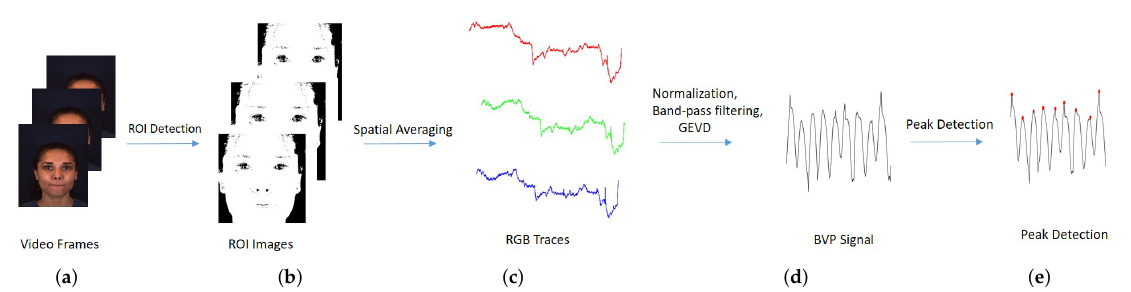
Figure 4. System Framework. ( a ) The original video frames. ( b ) The detected skins. The white part is the detected skin pixels and the black part is the non-skin pixels. ( c ) Spatially averaged RGB signals. ( d ) BVP signal. ( e ) Peak